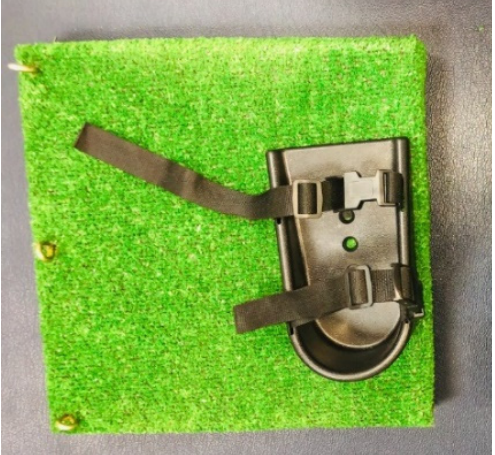
Figure 2. Shoe supporter.